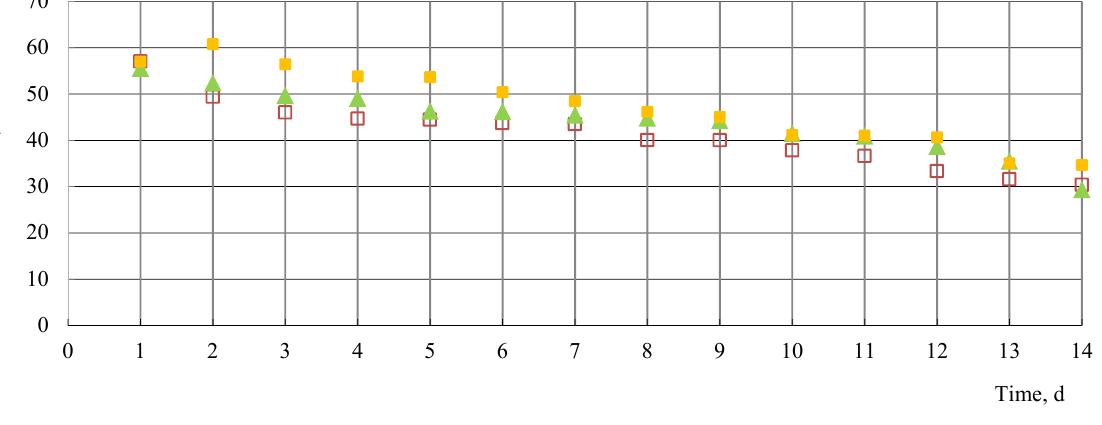
Figure 5. The moisture of the waste registered in the three parts of the drying reactor.